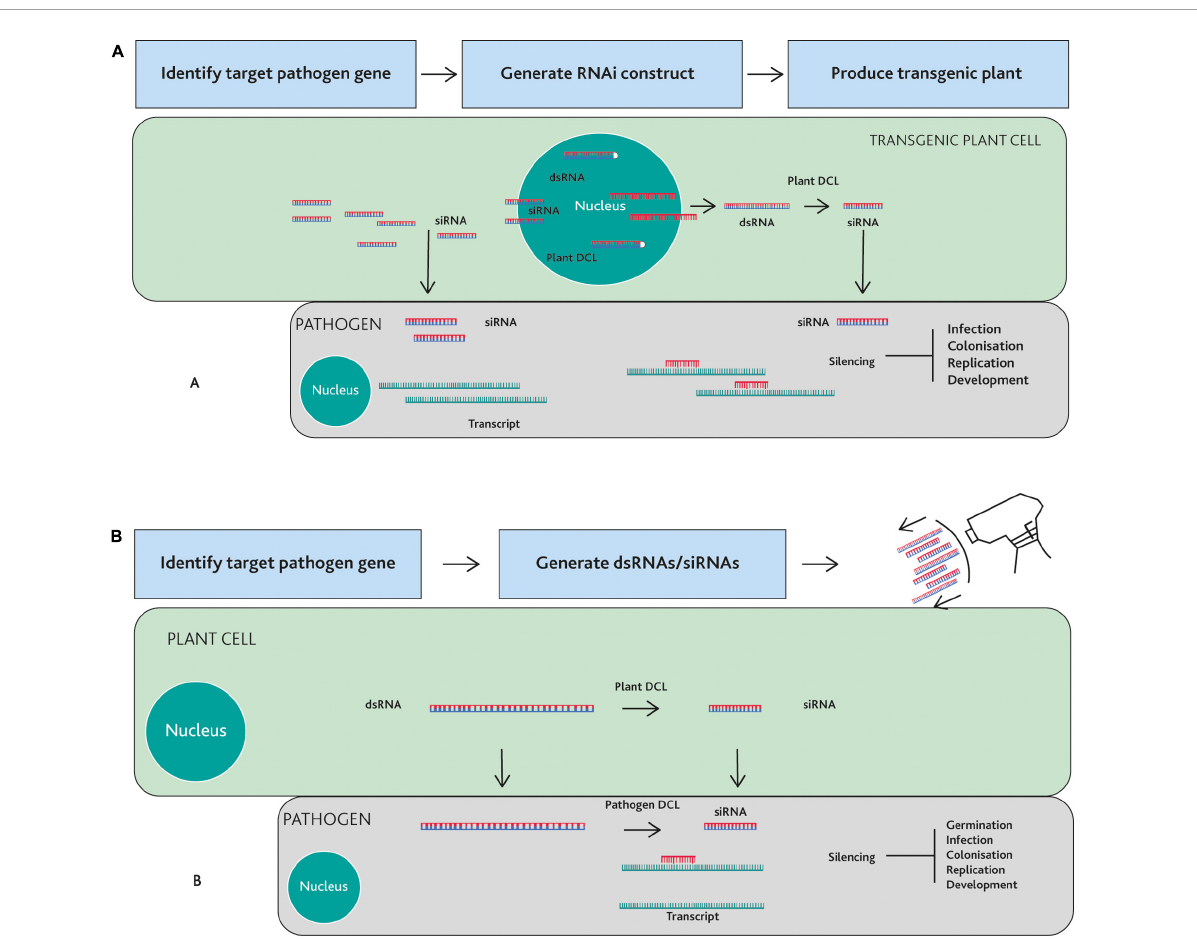
FIGURE1 Strategies to control plant pathogens using Host-Induced Gene Silencing (HIGS) or Spray Induced Gene Silencing (SIGS). (A) HIGS: A target gene is identified in the pathogen and an RNAi construct is generated from the part of the target gene sequence. Plants are transformed with the construct and transgenic lines are selected. The transgenic plant cell produces double stranded RNA (dsRNA), which are subjected to the cleavage by the plant Dicer-like (DCL) proteins within the nucleus and/or cytoplasm, producing small interfering RNA (siRNAs) that translocate to the pathogen cell. siRNAs guide the RNA silencing machinery of the pathogen cell to silence mRNAs from the target gene. (B) SIGS: dsRNAs or siRNAs targeting a pathogen gene are synthesized and sprayed onto plants. Sprayed dsRNAs are directly taken up by fungal cells or are taken up by plant cells and then transferred into fungal cells. Plant or pathogen Dicer-like (DCL) proteins cleaves these dsRNAs into siRNAs. In this case, dsRNAs are likely cleaved in the cytoplasm although this process could also occur in the nucleus. Resultant siRNAs guide the RNA silencing machinery of the pathogen cell to silence targeted mRNA. Depending on the function of the target gene, HIGS- or SIGS-mediated gene silencing can lead to inhibition of spore germination, infection, colonization, replication, or development of the